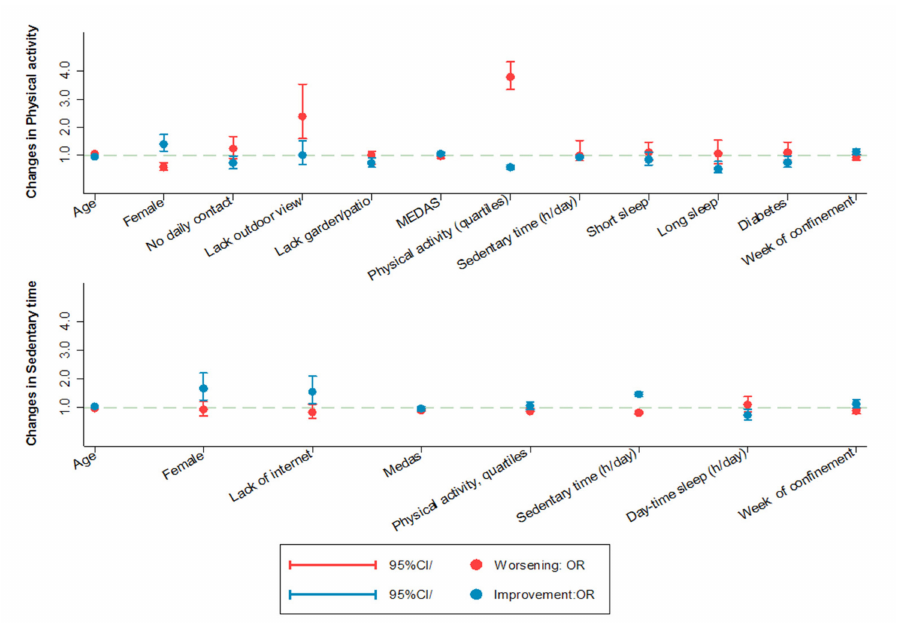
Figure 3. Prospective association between baseline participant characteristics and changes in physical activity and sedentary time during